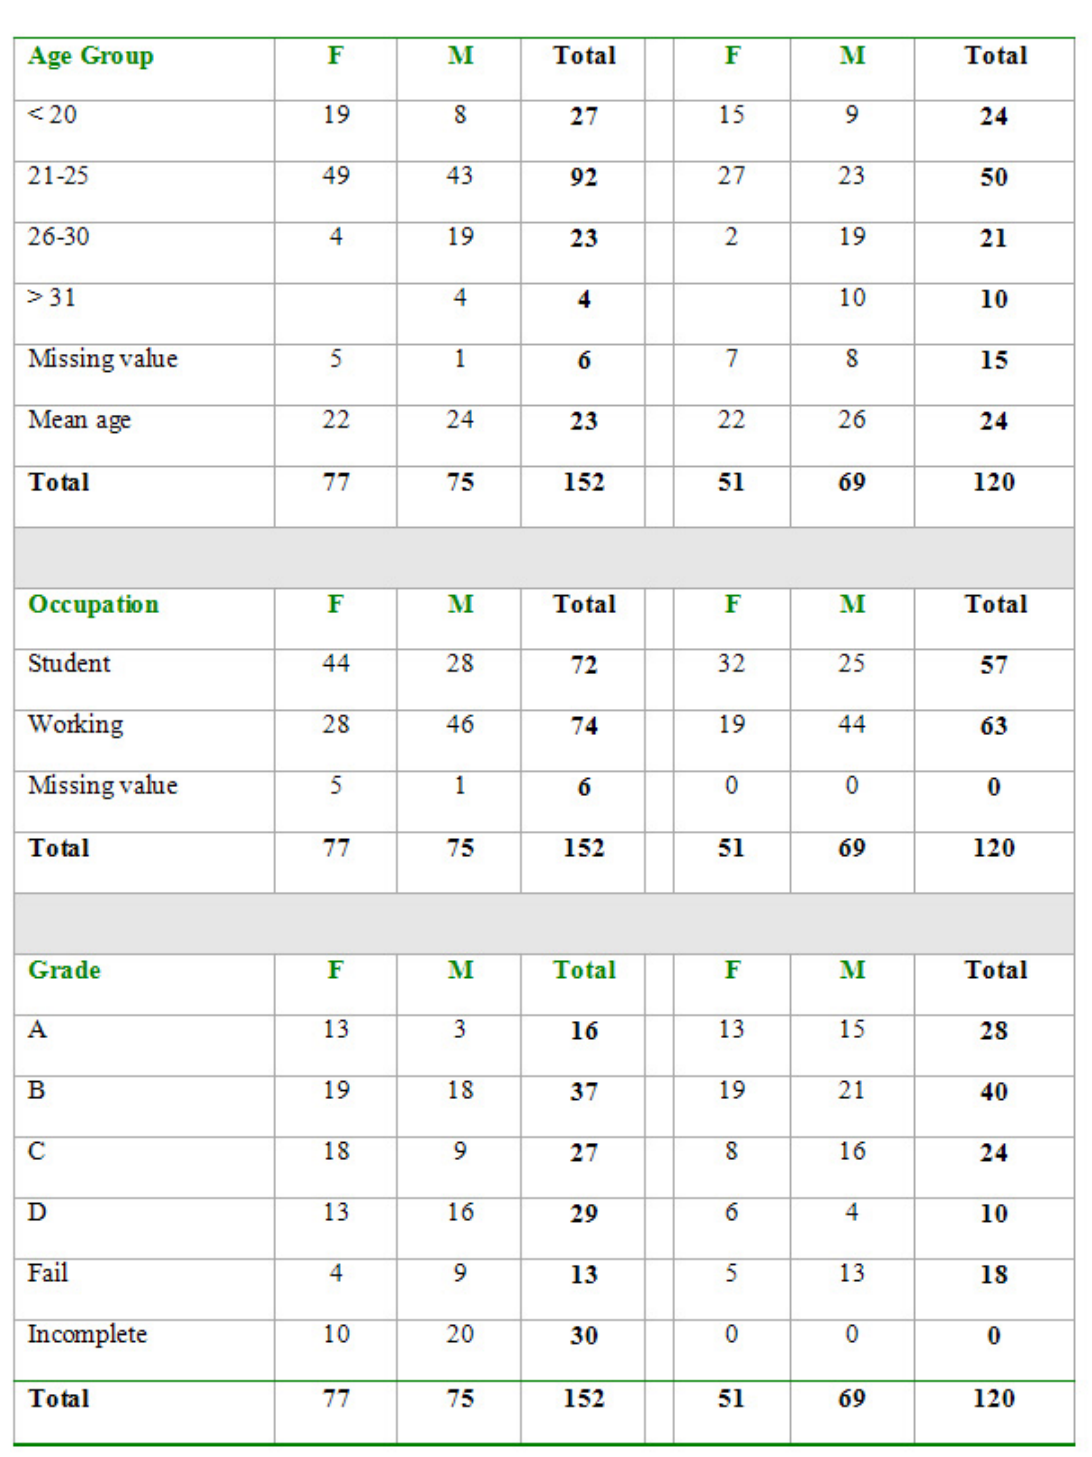
Table 3. Characteristics and Performance of Students Who Registered for Project eLearning